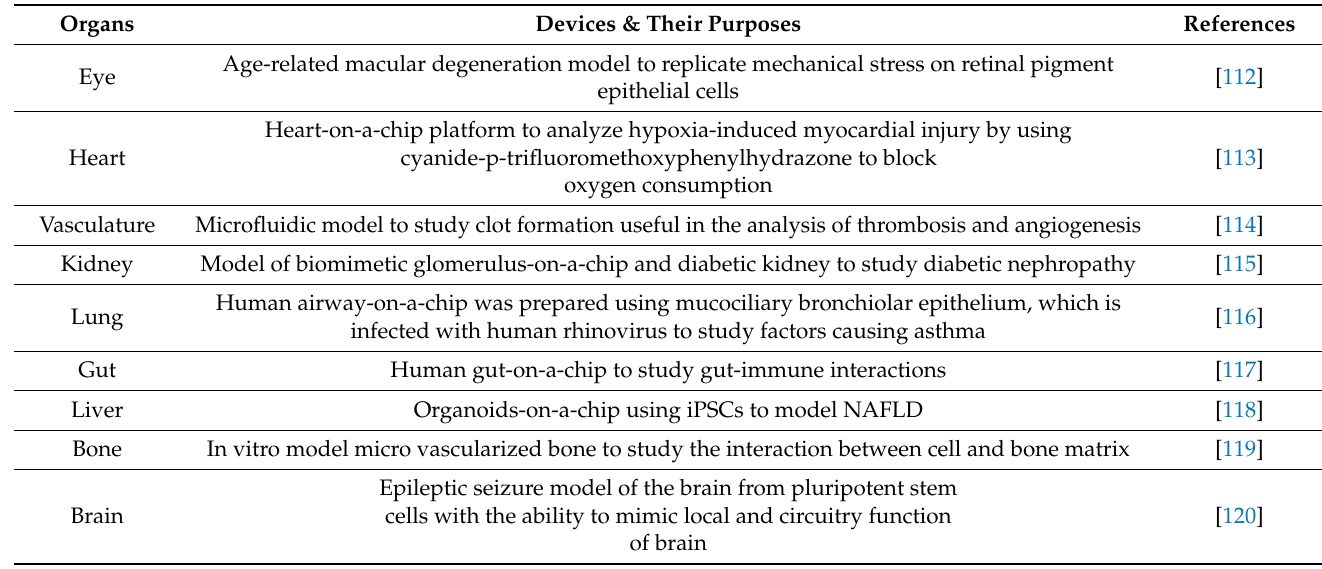
Table 4. Some examples of OOAC technology used for organ/disease